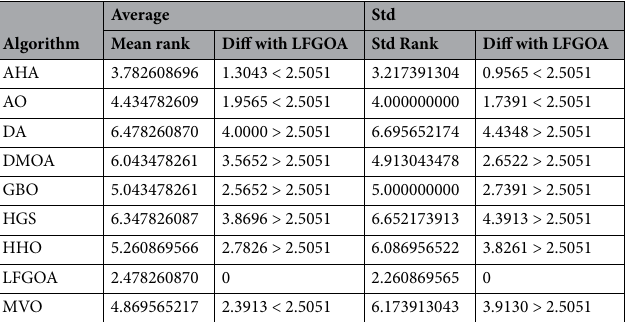
Table 7. The Average and Std ranks of nine algorithms using Friedman’s test based upon their results on the 23 test